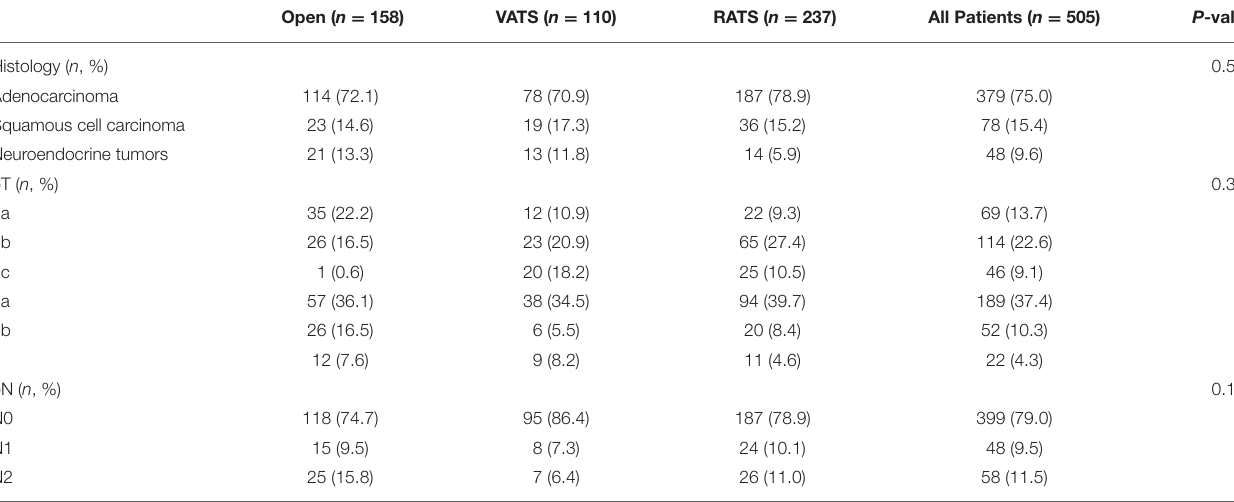
TABLE 2 | Histopathological and staging features in the Robotic, VATS, and Thoracotomy groups. Open ( n = 158) VATS ( n = 110) RATS ( n = 237) All Patients ( n = 505) P